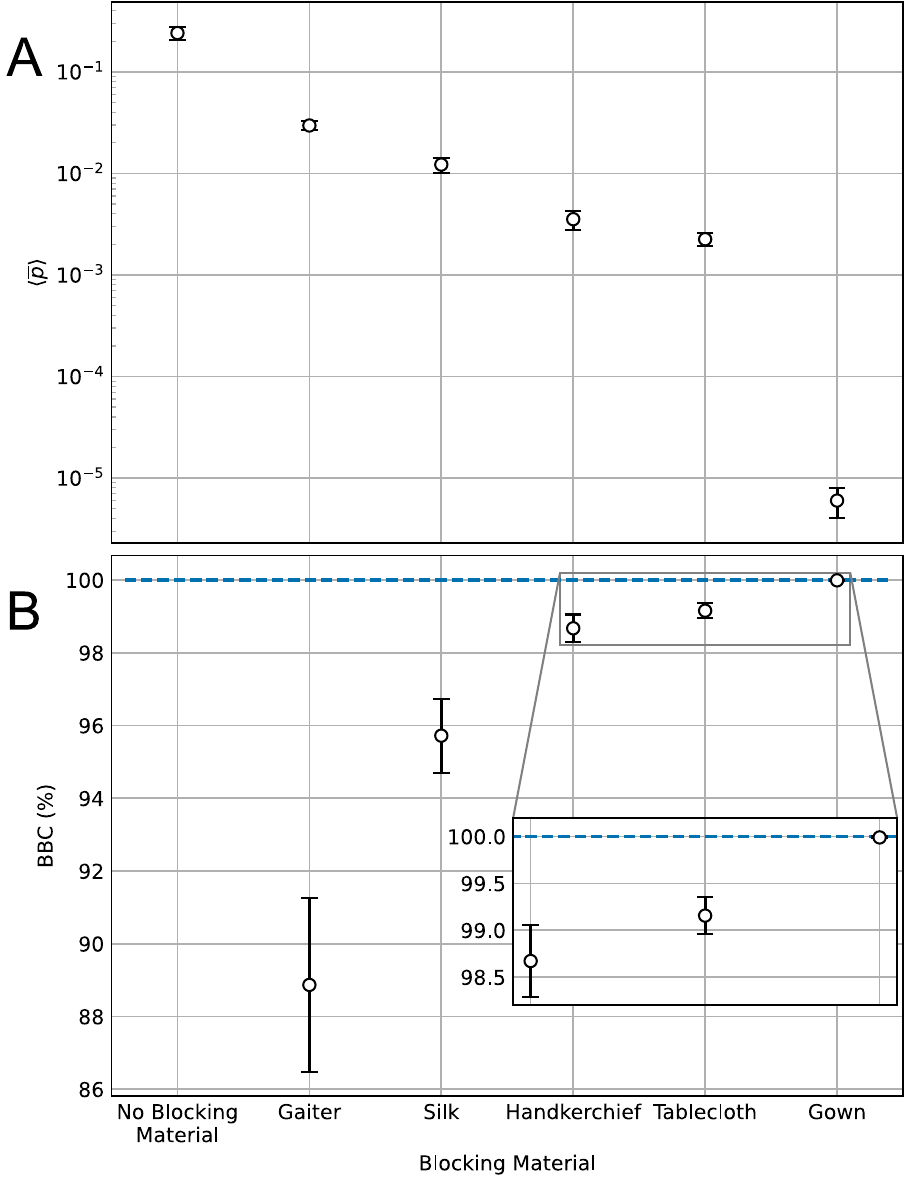
� i for no blocking material in CONFFREE, and of h � p no � i and h � p � i have been labeled as h � p � i ). (B) BBC for the no o